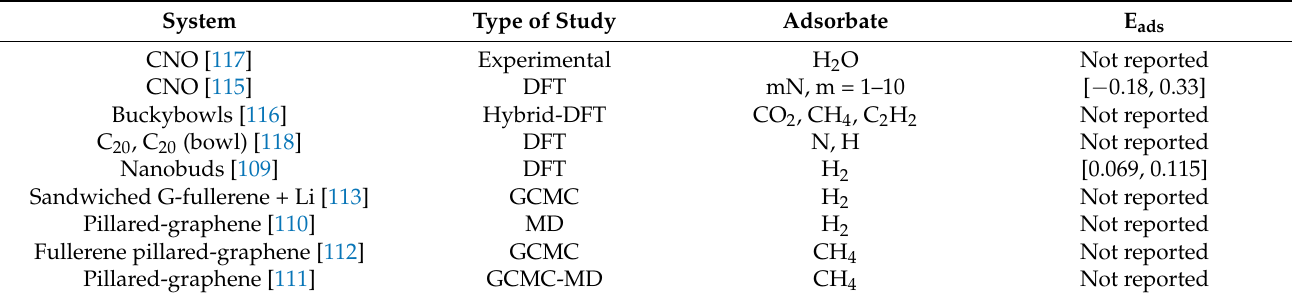
Table 5. Summary of adsorption energies E ads (in eV) for different non-metallic doped hybrid systems and adsorbates. The type of study is also